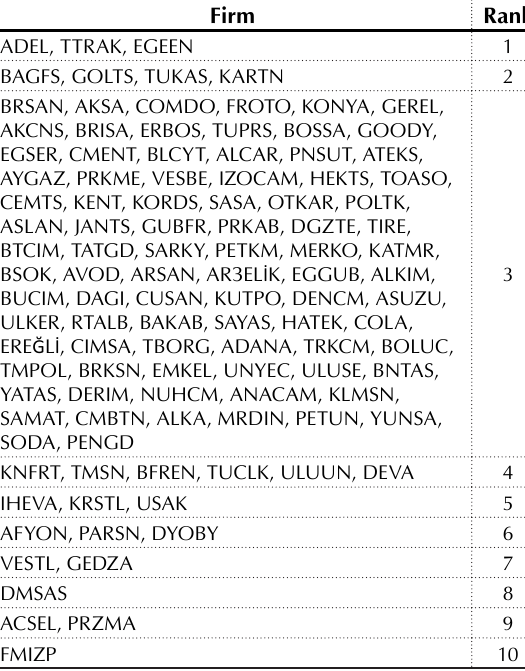
Table 9. The firm ranking by the VIKOR Firm Rank